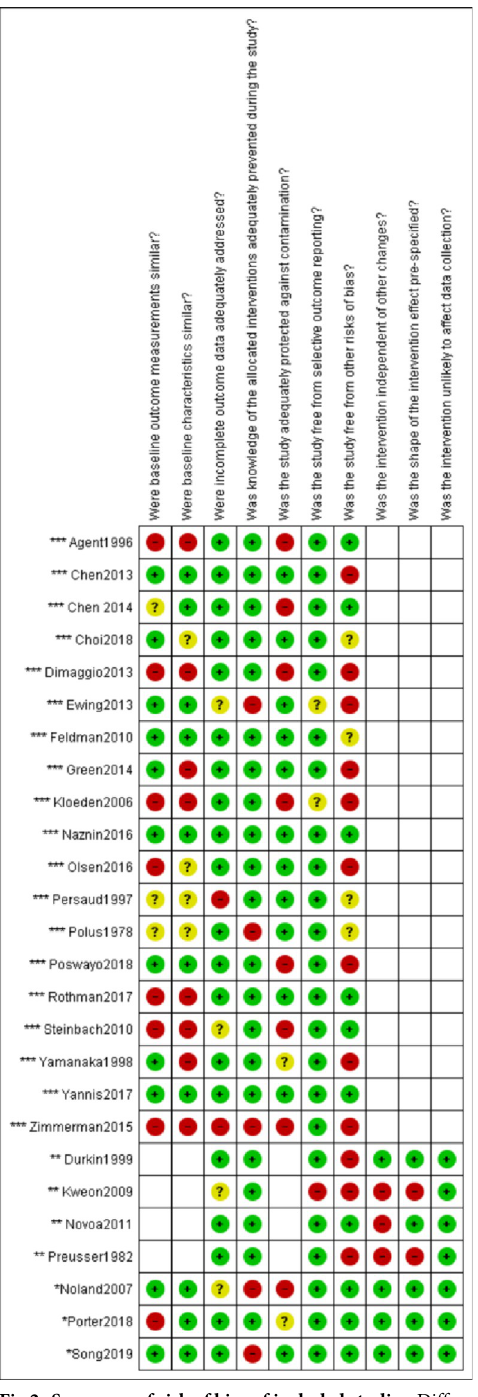
Fig 2. Summary of risk of bias of included studies. Different domains were applied to different study designs. � cITS study; �� uITS study, ��� CBA study.